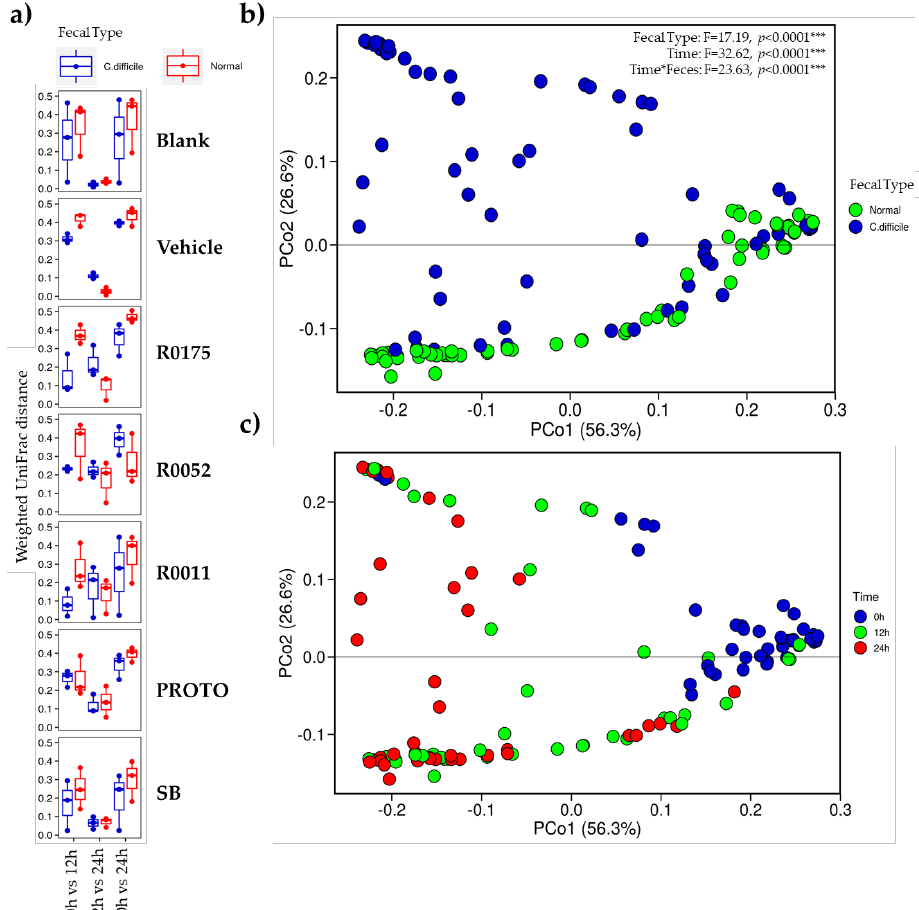
Figure 7. Beta diversity plots of normal fecal samples, and Clostridium ( C. ) difficile -infected fecal samples showing ( a ) Weighted UniFrac distance and PCA plots ( b ) clustered by type of feces, and ( c ) clustered by time. R0011 = L. rhamnosus R0011; R0052 = L. helveticus R0052; SB = S. boulardii CNCM I-1079; R0175 = B. longum R0175; PROTO = ProtecFlor TM .